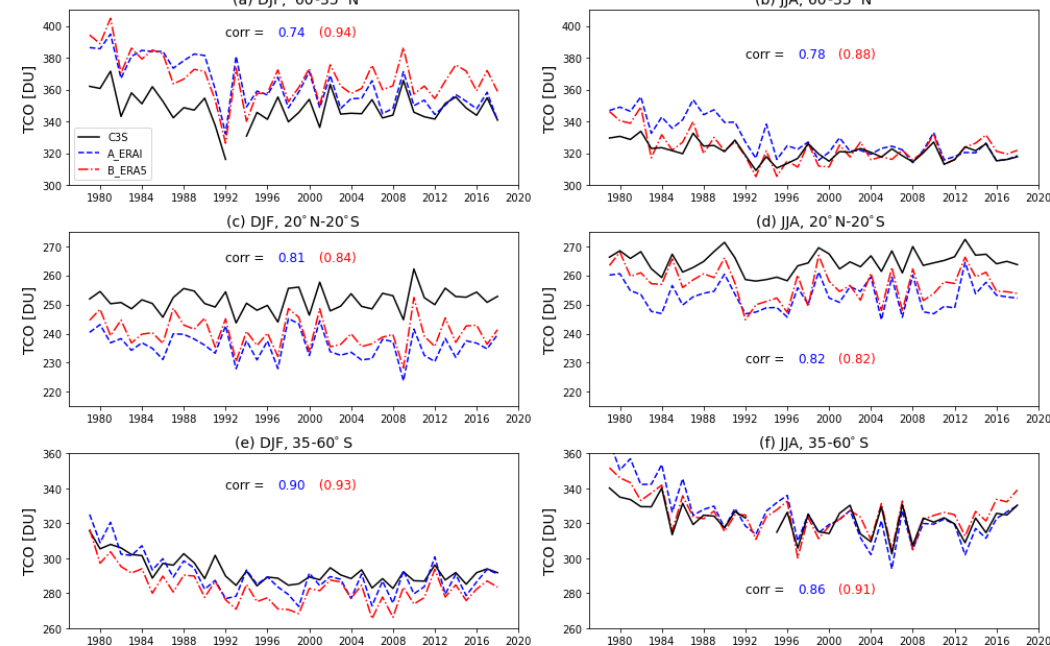
Figure 3. December–January–February (DJF) and June–July–August (JJA) mean TCO (DU) for the period 1979–2018 from C3S (black solid line), A_ERAI (blue dashed line), and B_ERA5 (red dash-dotted line) averaged over the latitude bands (a, b) 60–35 ◦ N, (c, d) 20 ◦ N– 20 ◦ S, and (e, f) 35–60 ◦ S. Correlation coefficients between simulation A_ERAI (B_ERA5) and C3S are shown in each panel with blue (red) text. Note that y axes change for different